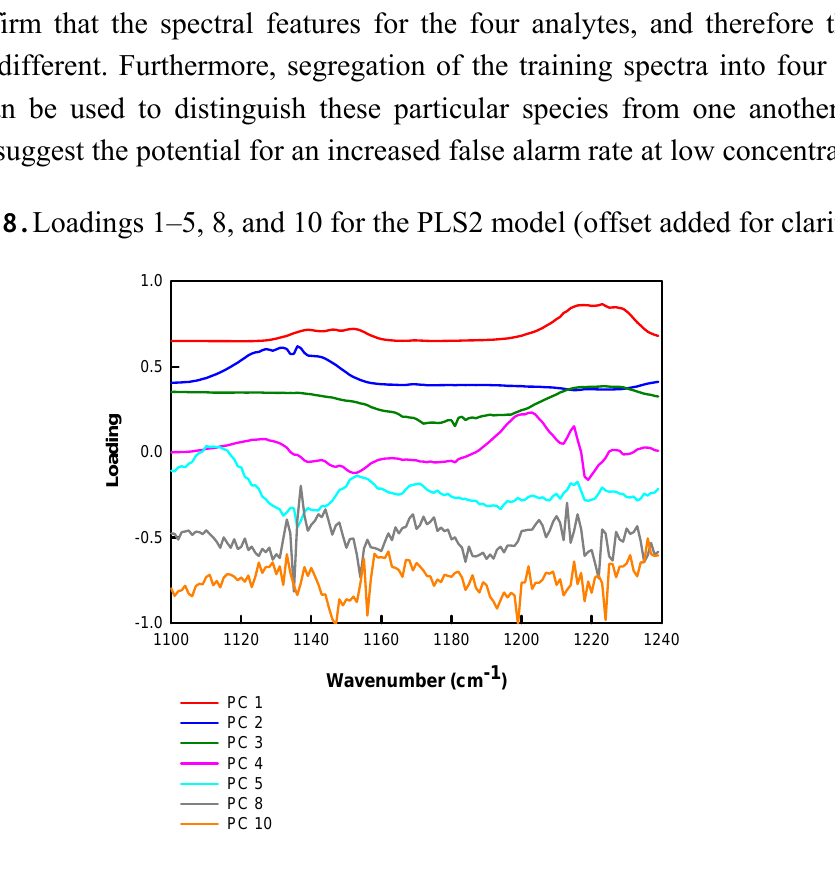
Figure 9. Scores plot for the PLS2 model, using the first three calculated